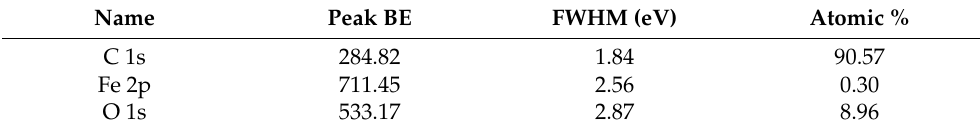
Figure 4. ( a ) XPS survey spectra and deconvoluted spectra of ( b ) Fe 2p, ( c ) O 1s, and ( d ) C 1s. Table 2. The atomic concentration of XPS analysis of AC/Fe 2 O 3